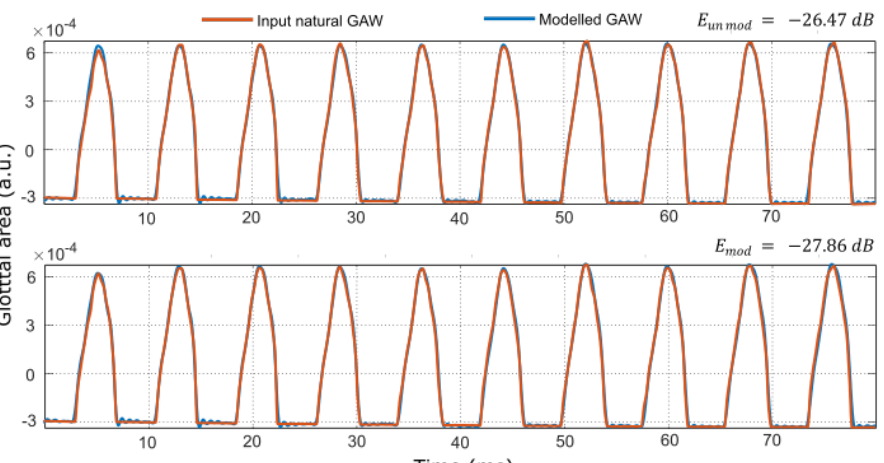
Figure 6. Modelling of an example of a natural euphonic GAW using the nonmodulating model (top plot) and the modulating model (bottom plot).